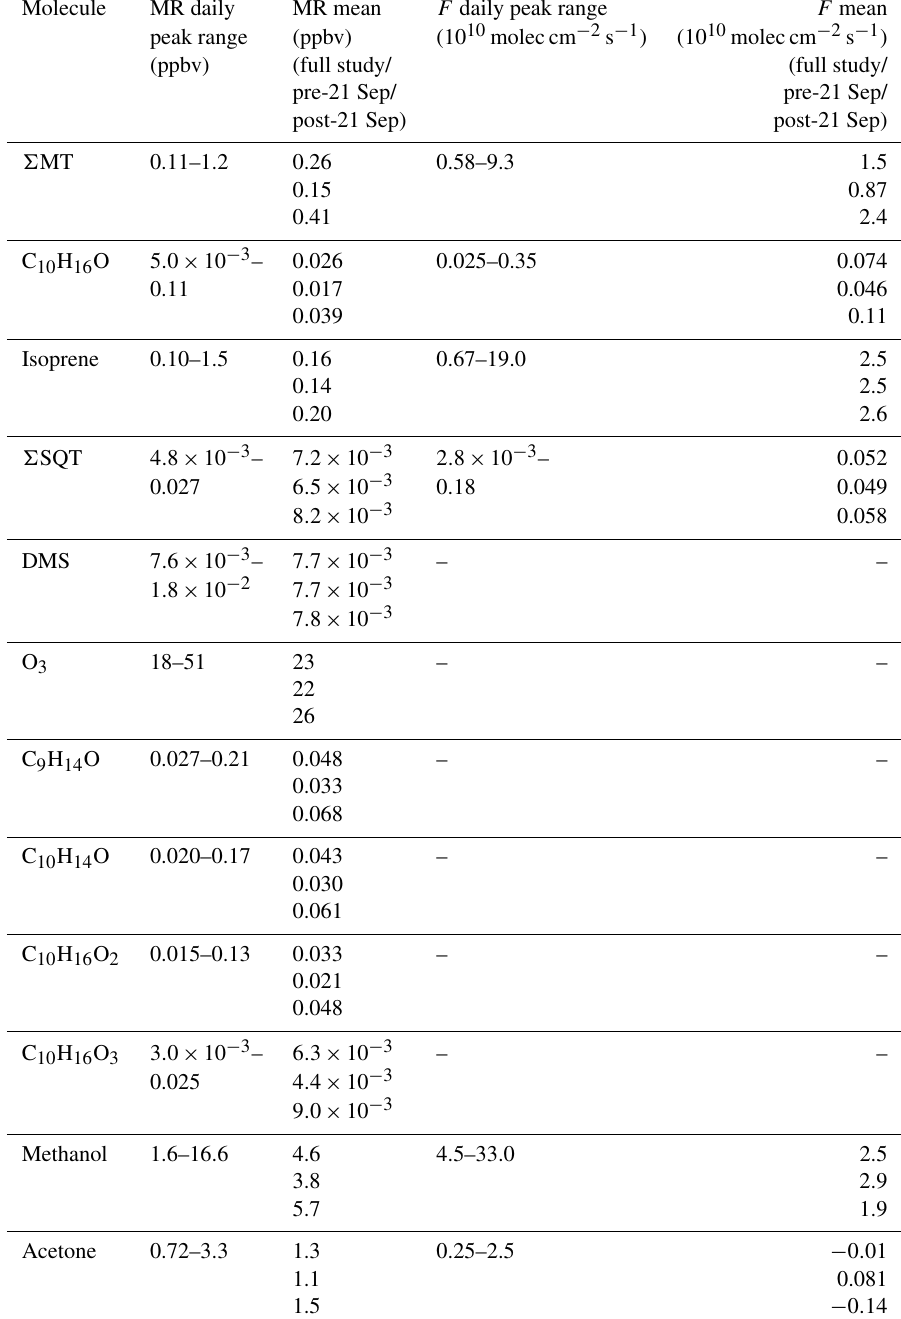
Table 1. Summary of mixing ratios (MR) and fluxes ( F ) of select compounds during the PEcoRINO study.